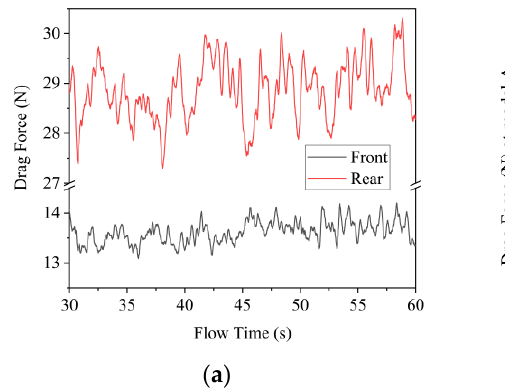
Figure 10. Value of 90 s −2 Q-criterion distribution for model B.